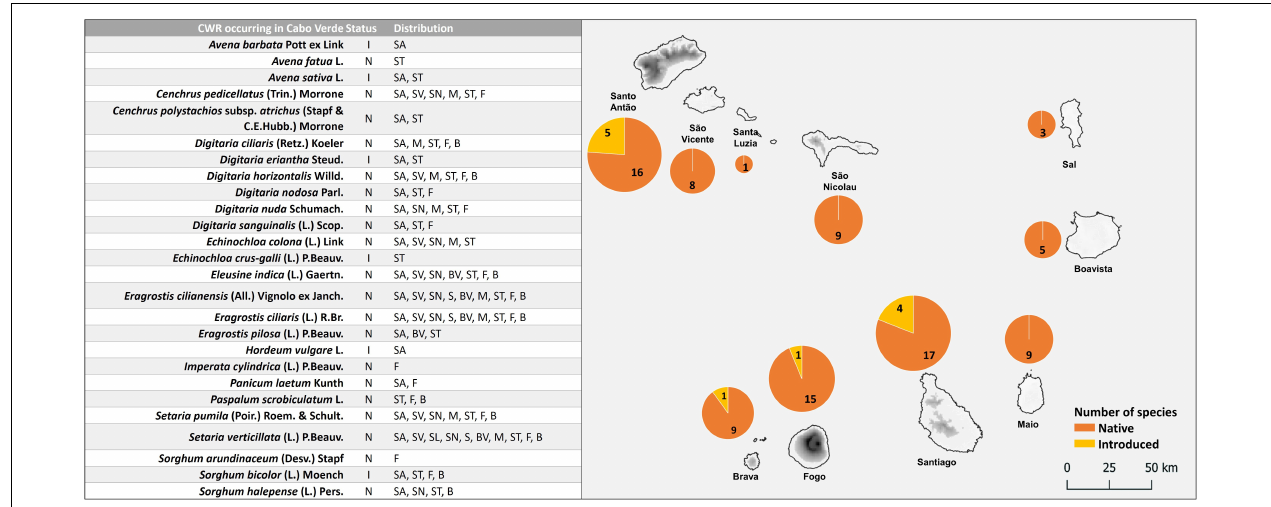
FIGURE 1 | Crop wild relatives (CWR) Poaceae species occurring in Cabo Verde: status and distribution in the archipelago. The area of the circles is proportional to the number of species. Status: I, introduced; N, native. Island abbreviations: SA, Santo Antão; SV, São Vicente; SL, Santa Luzia; SN, São Nicolau; S, Sal; BV, Boavista; M, Maio; ST, Santiago; F, Fogo; B,